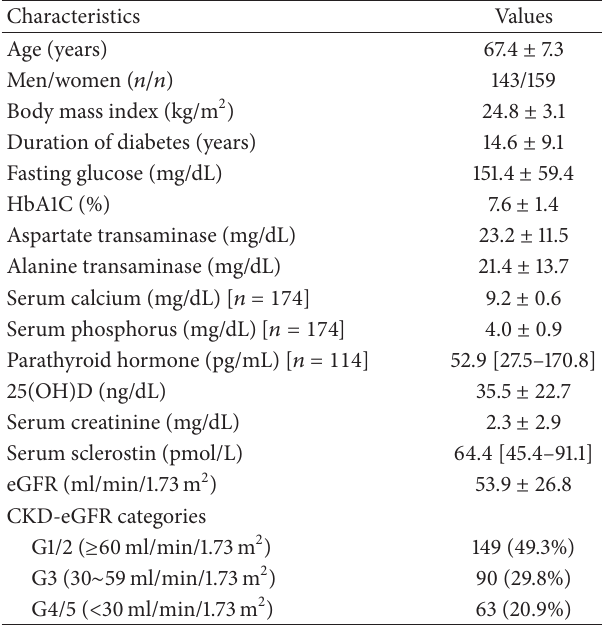
Figure 1: Serum sclerostin levels according to CKD groups in patients with type 2 diabetes. Values are expressed as mean ± SE. Table 1: Clinical and biochemical characteristics of patients ( 𝑛 = 302